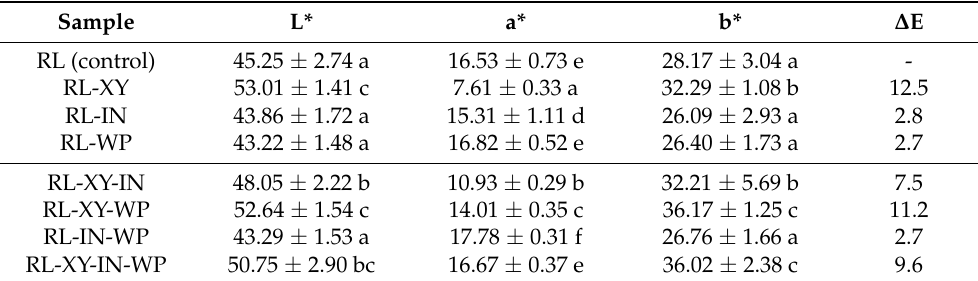
Table 5. Color parameters of red lentil